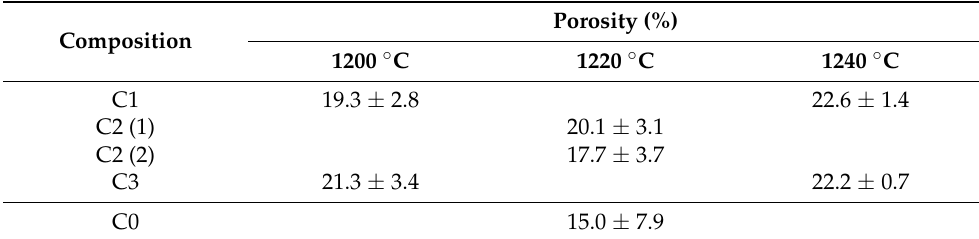
Table 7. Porosity of studied compositions at different